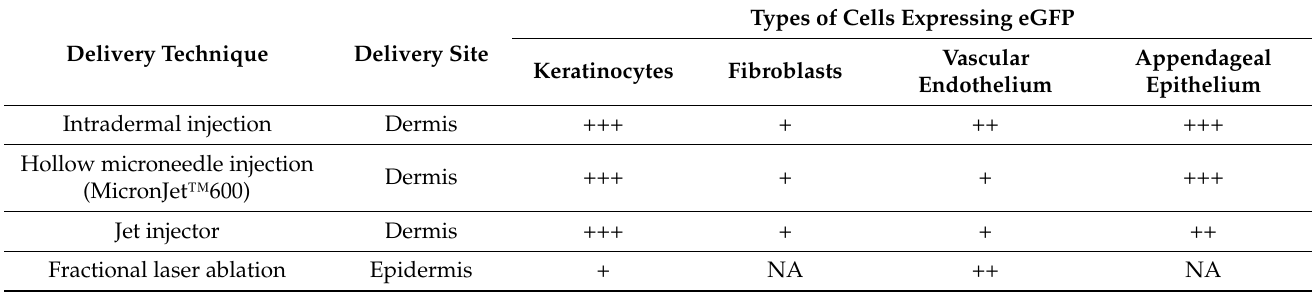
Table 2. Site of mRNA delivery and extent of eGFP expression by the different skin